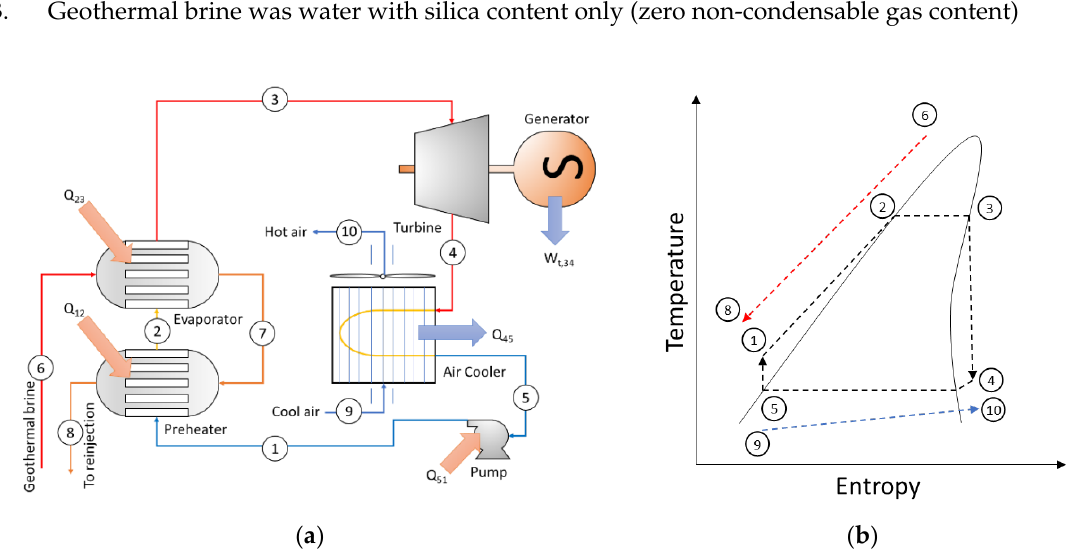
Figure 3. ( a ) Schematic and ( b ) temperature-entropy diagram of the benchmark cycle